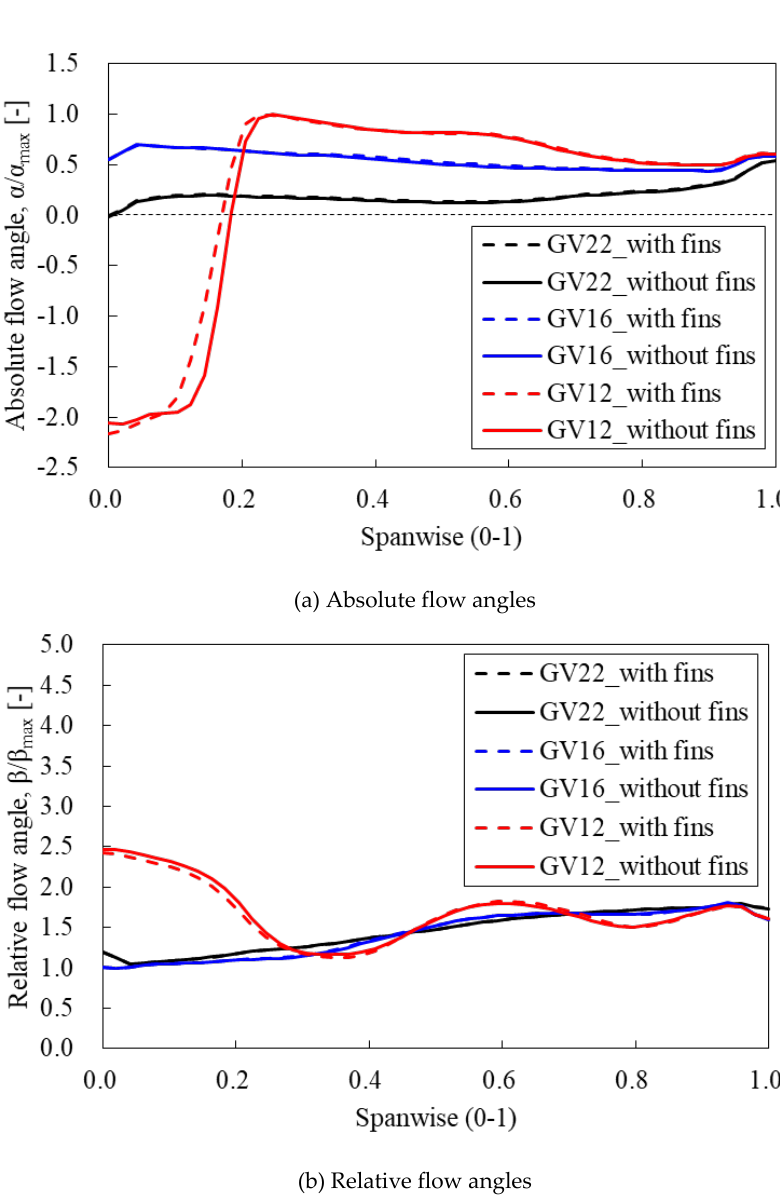
Figure 12. (a) Absolute and (b) relative flow angle distributions along the spanwise direction at the outlet of the runner at GVs of 22°, 16°, and 12°. outlet of the runner at GVs of 22 ◦ , 16 ◦ , and 12 ◦